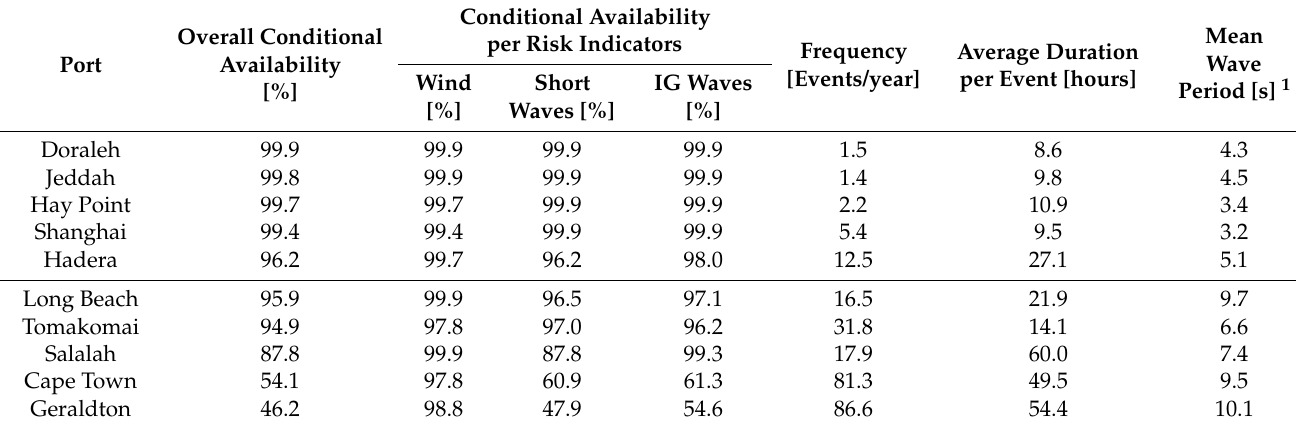
Figure 4. The overall conditional availability for 10 (existing) port locations including drivers (dotted lines). The left 5 ports have an open layout and the right 5 are known for operability issues. Input/thresholds used in the methodology are given in the lower right corner. Table 2. Outcomes of the validation study for 10 (existing) port locations. The top 5 ports have an open layout and the bottom 5 are known for operability